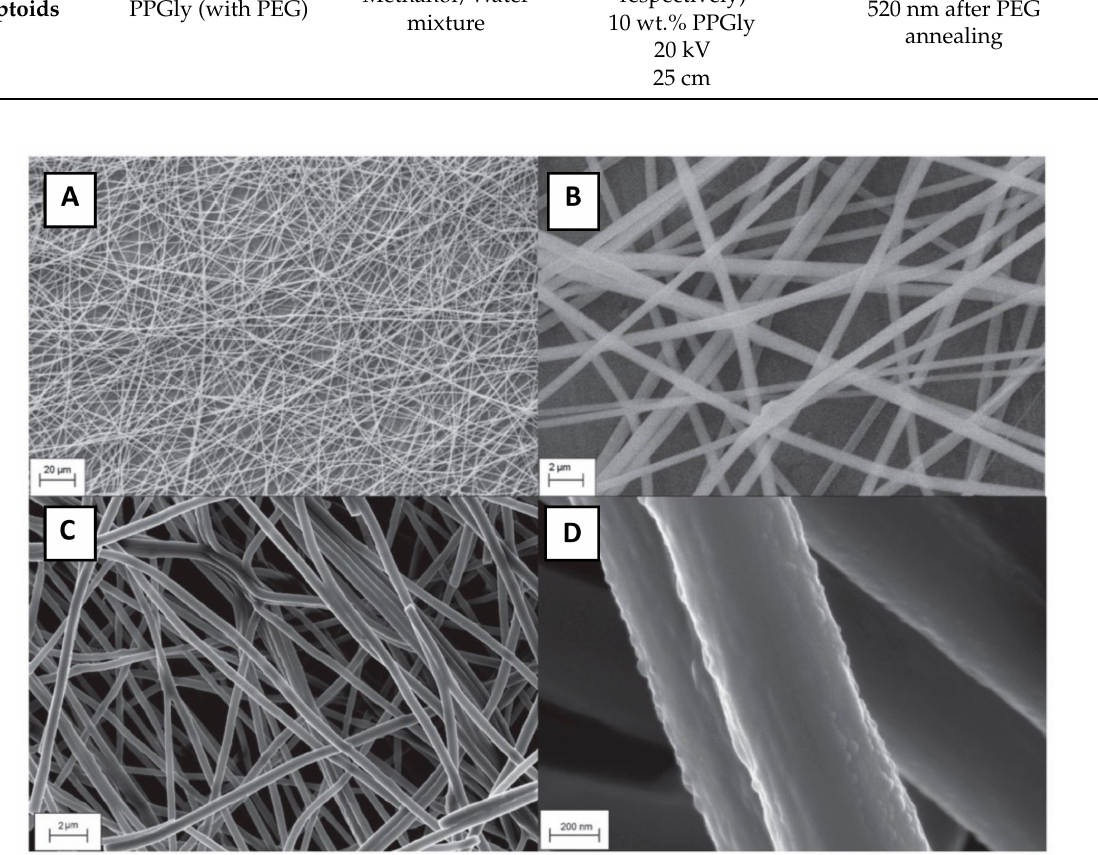
Figure 11. SEM images of electrospun PEG/PPGly fibers ( A , B ) and PPGly fibers after annealing and washing of PEG ( C , D ). Reproduced from [90] with permission from